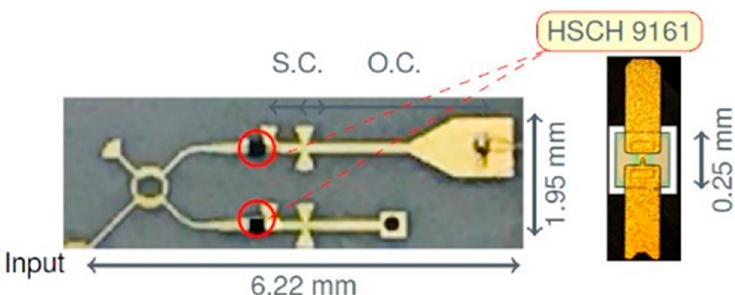
Figure 12. Miniature hybrid microwave integrated circuits (MHMIC) power detector using two HSCH GaAs Schottky